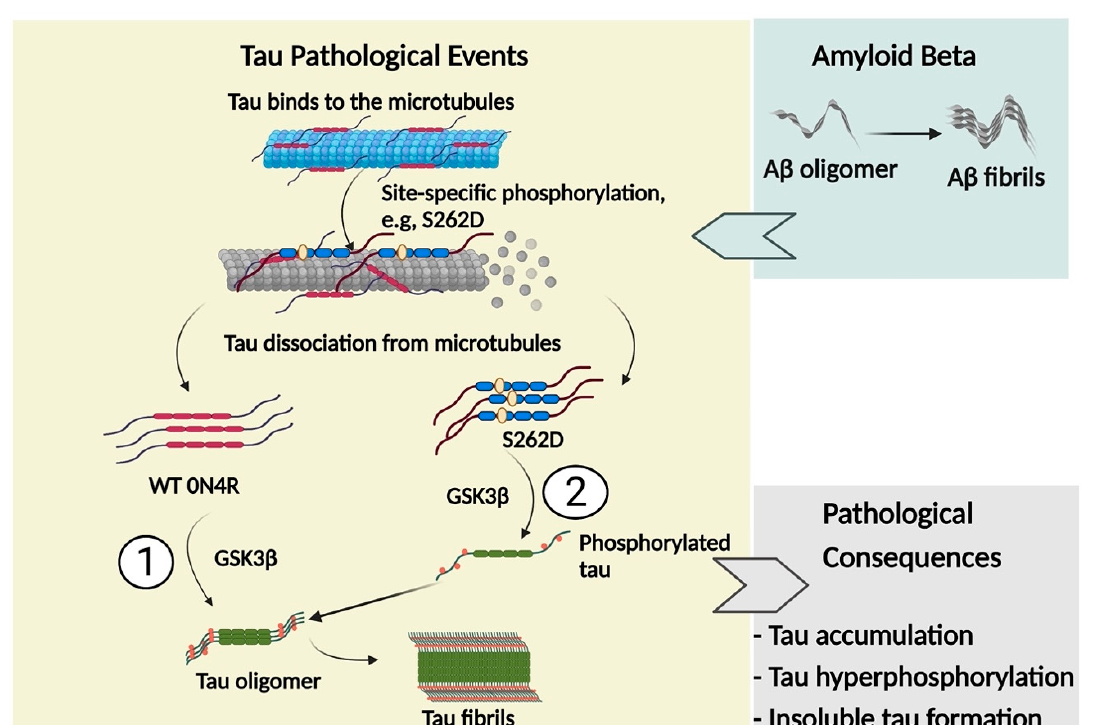
Figure 12. Tau intracellular aggregation and fibril formation appears to result from a series of temporally ordered phosphorylation steps. Site-specific phosphorylation at Ser262 leads to the dissociation of tau from microtubules due to the reduced affinity for microtubules. Addition of A β 42 oligomers facilitates Ser262 phosphorylation, which may accelerate tau pathology. Cellular tau that is dissociated from microtubules is more accessible to tau kinase GSK3 β , which phosphorylates tau further at AD-related sites, such as AT8+ targeted epitopes. Eventually, tau hyper-phosphorylation leads to increased insoluble tau formation. We also observed the activity of GSK3 β highly depends on the substrate and can follow two paths to form fibrils (1) GSK3 β facilitates tau oligomerization when phosphorylating WT 0N4R. (2) The phosphorylation of tau variant, S262D, can lead to insoluble tau formation Created with BioRender.com; last accessed on 8/29/2022.